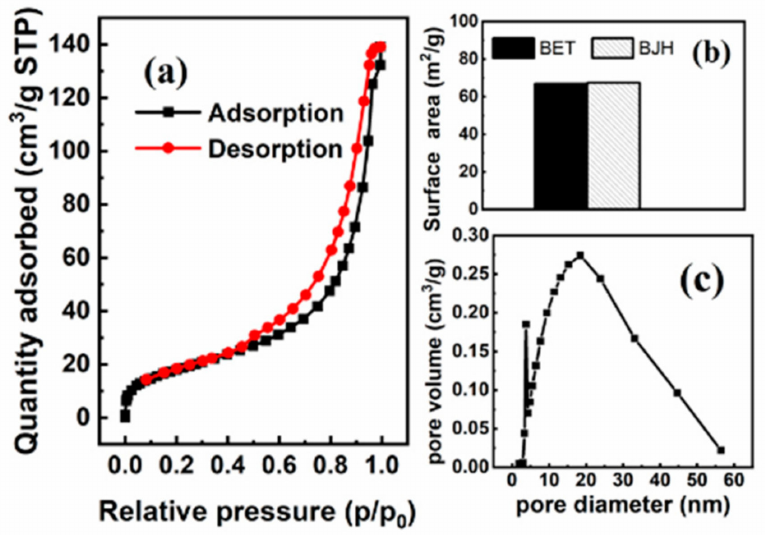
Figure 1. BET analysis of the MGOCS: ( a ) adsorption/desorption isotherm plots, ( b ) bar graphs of the BET and BJH surface areas, and ( c ) BJH plots of the pore size